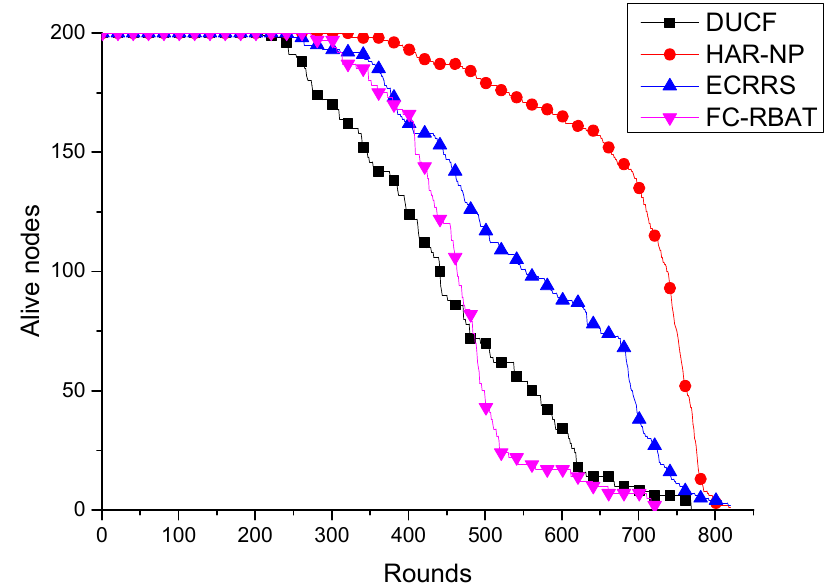
Figure 2. Comparison of the number of alive nodes.